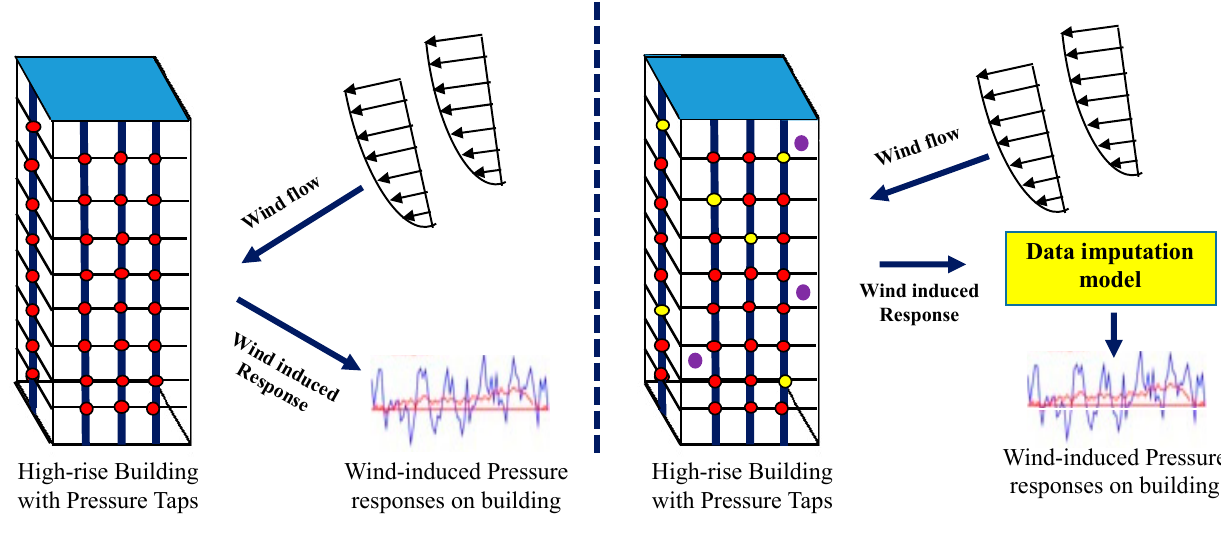
Figure 1. Data imputation model for analyzing wind-induced response.